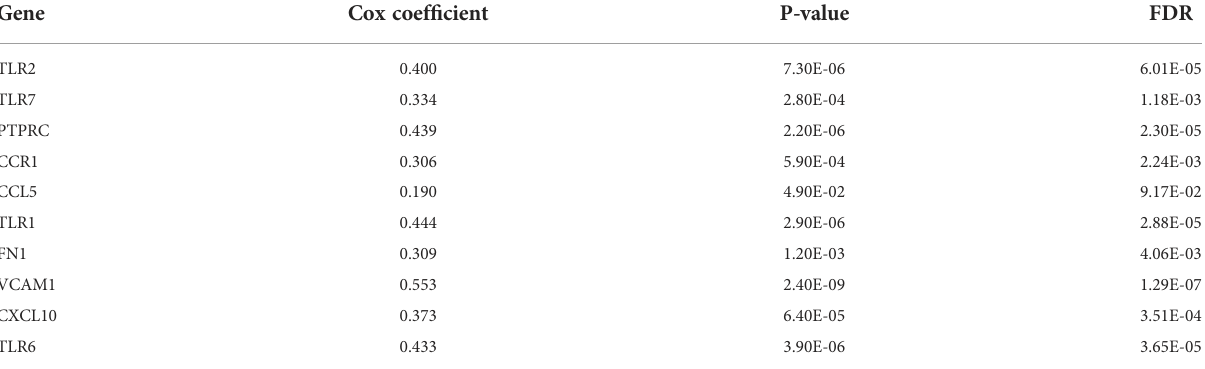
TABLE 3 Cox regression results of 10 hub genes in low-grade glioma